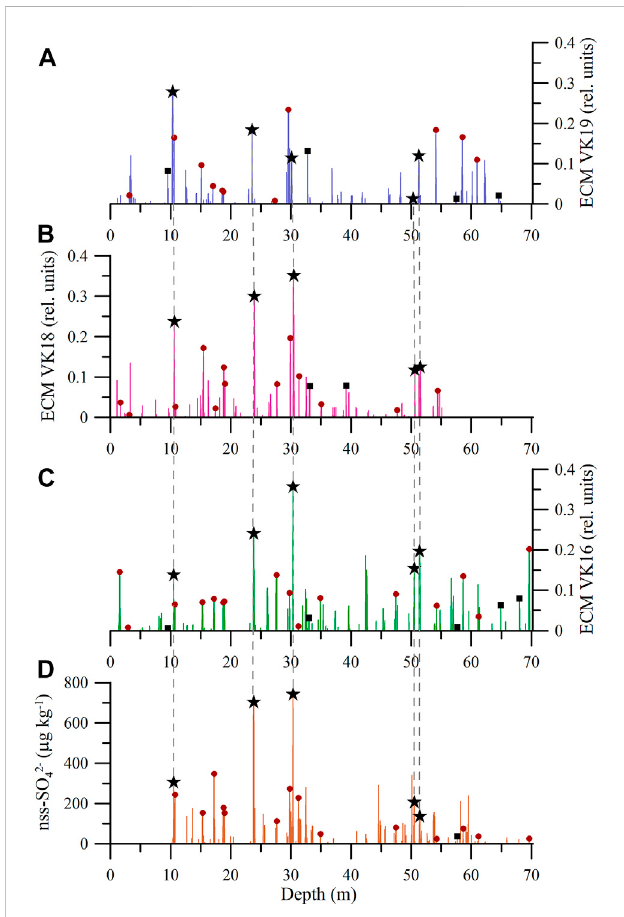
Volcanic peaks discovered in 9.90 – 70.20 m of (D) the nss-sulfate record of the VK16 core and in the ECM records of cores (A) VK19, (B) VK18 and (C) VK16. The stars denote the position of 5 peaks that can be unambiguously attributed to the well-dated volcanic events and thus served as a foundation of the core dating (see Discussion). The red circles are other peaks used in the dating, while the black squares are additional peaks used for the cross-dating of the three